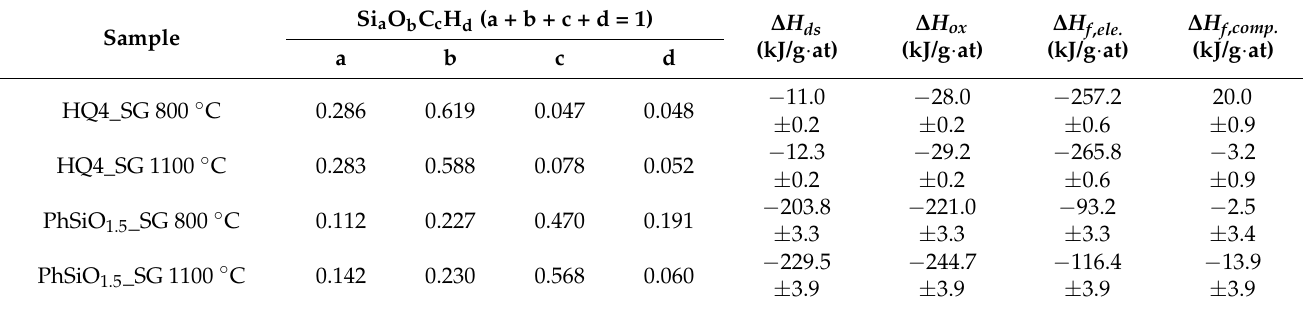
Table 6. Enthalpies of drop solution, enthalpies of oxidation at room temperature, enthalpies of formations from the elements and enthalpies of formation from the components for SiOC(H)